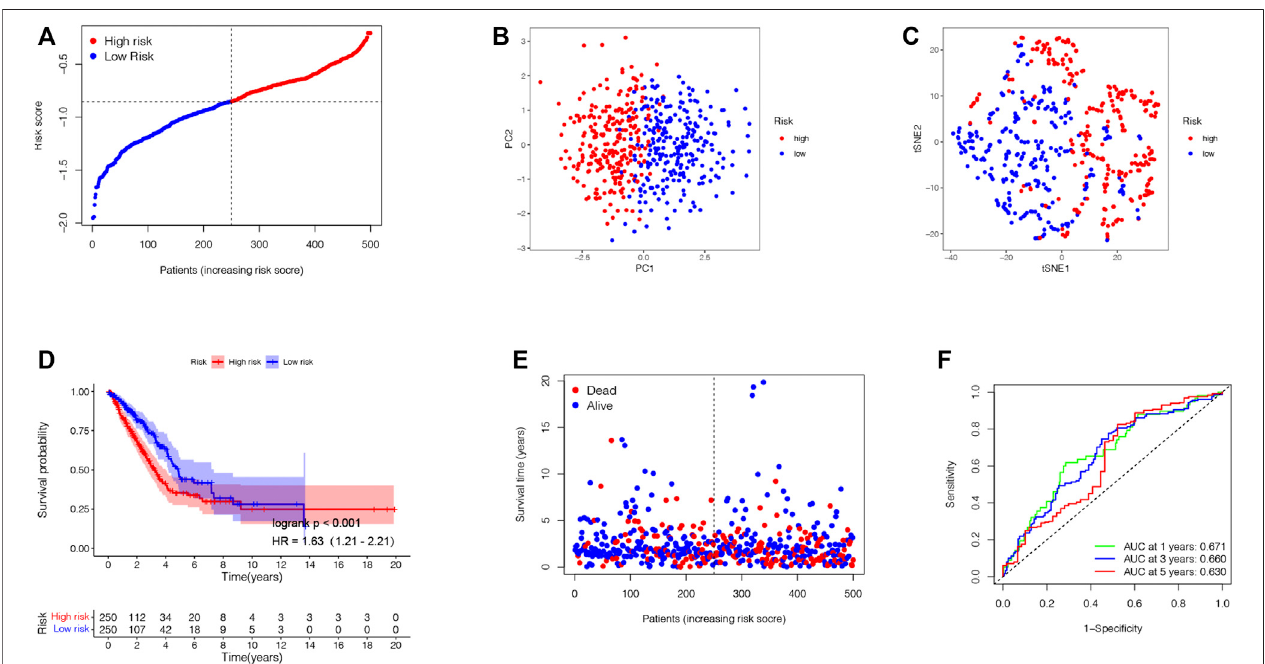
FIGURE5 | Establishment of the prognostic TRIGscore in the TCGA cohort. (A) . Spread ofsurvival status and risk scores ofthe TCGA cohort. (B,C) . Variations in the distribution of different TRIGs risk groups. (D) . Kaplan – Meier survival curve of OS of LUAD samples in the high- and low-risk groups. (E) . Survival status for each patient in low-risk and high-risk populations. (F) . AUC of time-dependent ROC curves showed the predictive ef fi ciency of the TRIG score.